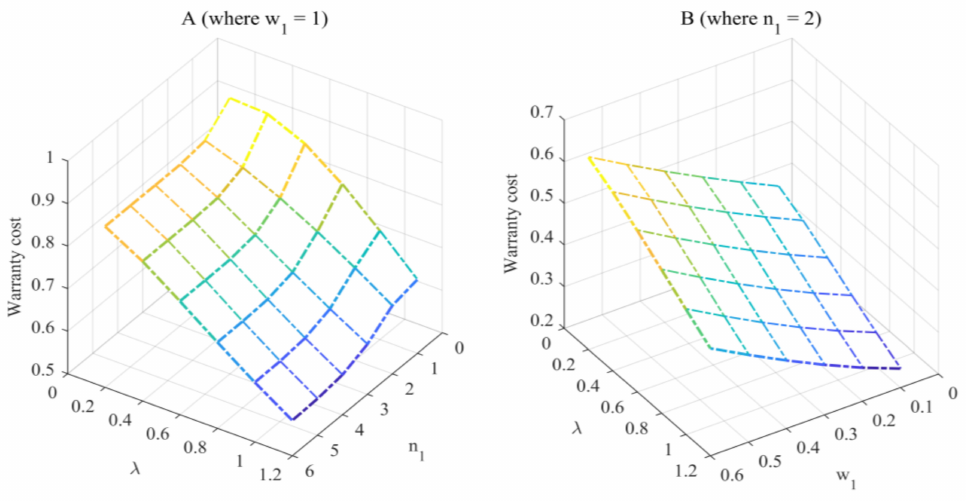
Figure 1. How n 1 , w 1 , and λ affect the two-stage 2DRFW.